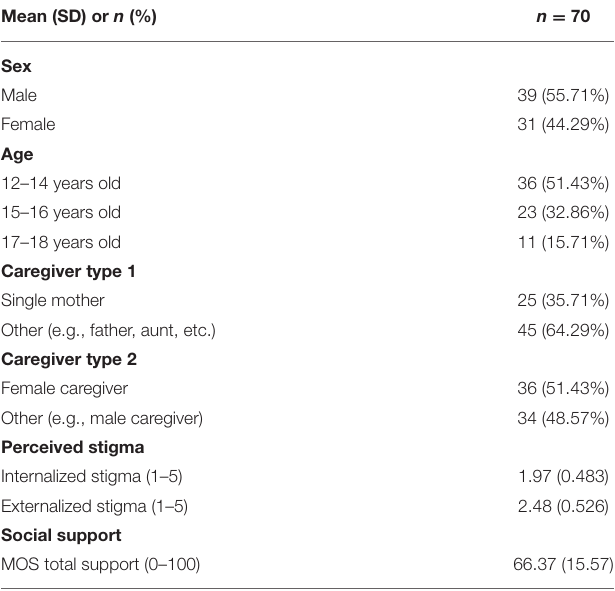
TABLE 1 | Characteristics of study sample.